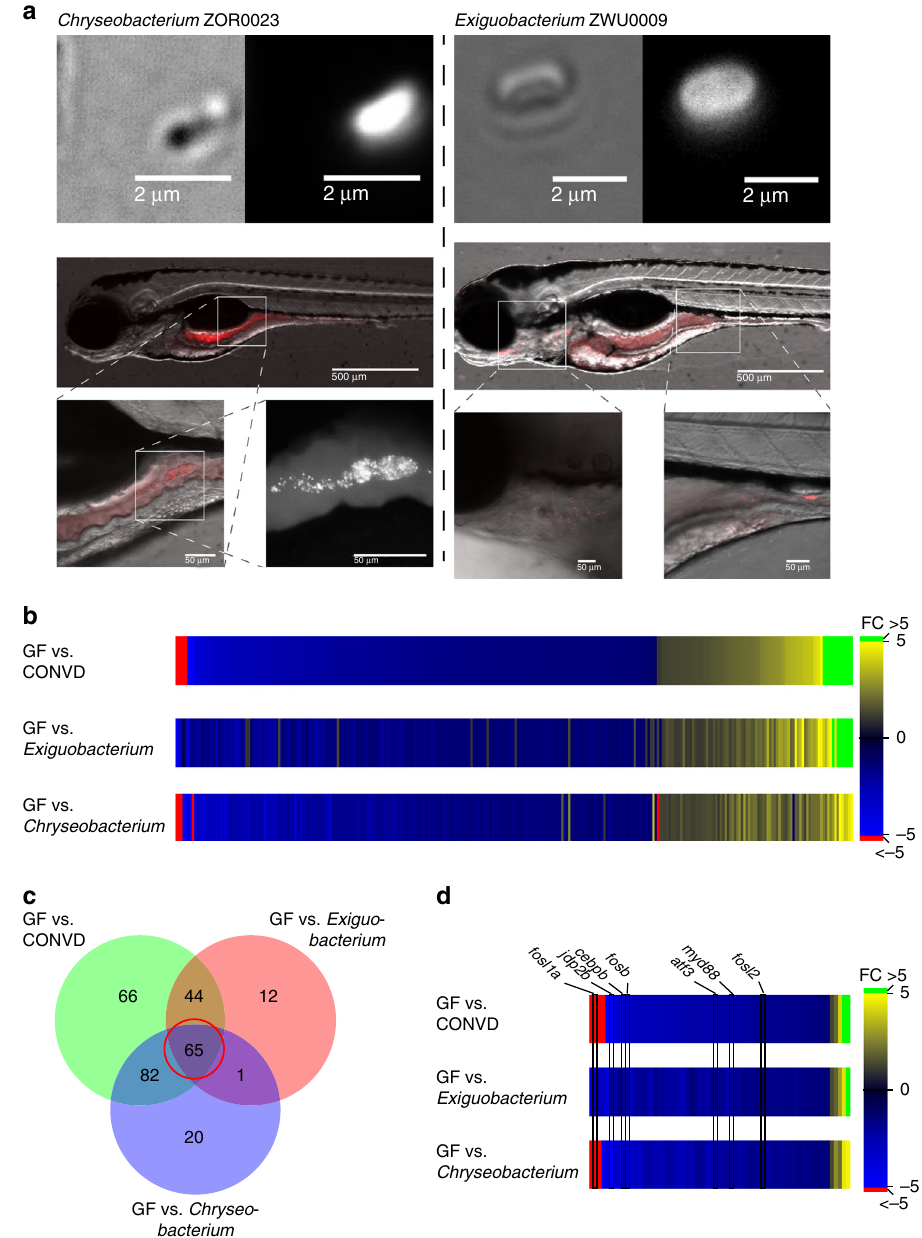
Fig. 3 Mono-associated treatment groups help re fi ne the colonization sensitive genes. a Chryseobacterium ZOR0023 (phylum Bacteriodetes) and Exiguobacterium ZWU0009 (phylum Firmicutes) visualized microscopically using the amine-reactive Dye-light fl uorescent labeling system, colonizes different parts of the intestinal tract of the larvae. By plating homogenized embryos, the colonizing CFU burden was estimated to be approximately 70 – 75 for each, colonization patterns represent observations made in three independent colonization experiments. b Heat map displaying the normalized fold changes of 290 transcripts which reached statistical signi fi cance as differentially expressed in at least one of the colonized samples compared to germ-free. c Venn diagram showing the overlap in genes that make the signi fi cance cut-off for differential expression in the different colonized groups versus germ- free. d The central group of genes in the Venn diagram de fi nes a group of 65 genes which all exhibit similar transcriptional responsiveness to bacterial colonization. These 65 genes represent strong candidates for markers of the shared transcriptional response. Myd88 , along with several transcription factor encoding genes known to function downstream of Myd88, are among